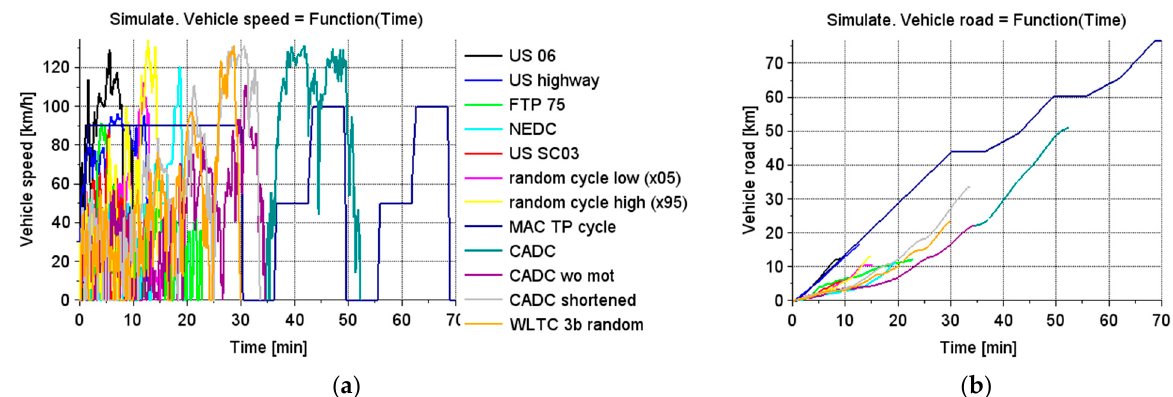
Figure 7. Results obtained in the simulation of selected road tests for the Toyota Camry LE 2018 vehicle: ( a ) waveforms of the instantaneous vehicle speed values; ( b ) waveforms of the instantaneous values of the distance travelled by the vehicle.